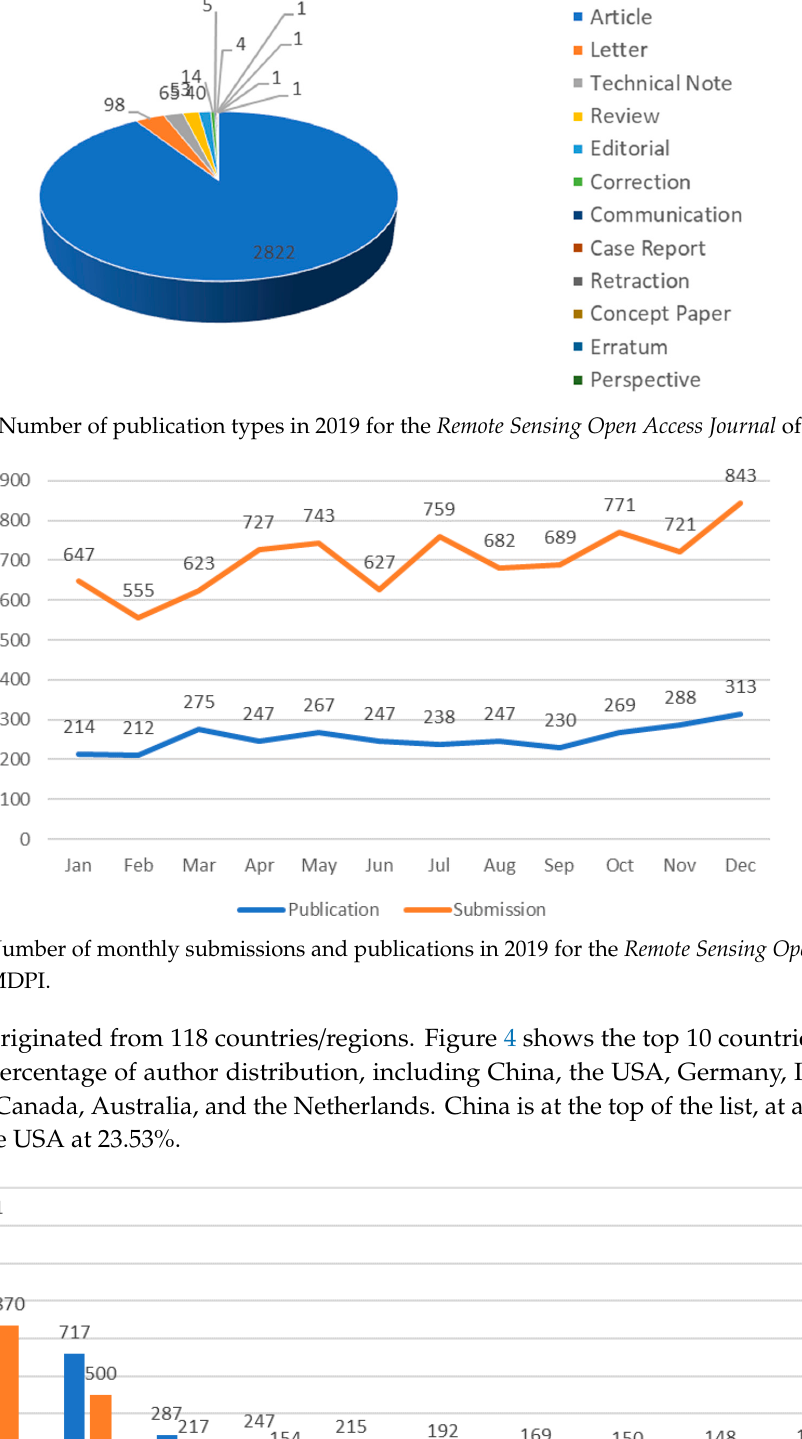
Figure 5. The average publication time (APT, blue), median publication time (MPT, red), and time from submission to first decision (TFD, green) in the past three years. 2.2. Special Issue (SI) In 2019, 451 SIs were set up, an increase of 45.95% compared with 2018 (Figure 6). Moreover, Figure 6 shows that the publication rate for SIs in 2019 was 71.02%, keeping a similar rate as 2018, as SIs